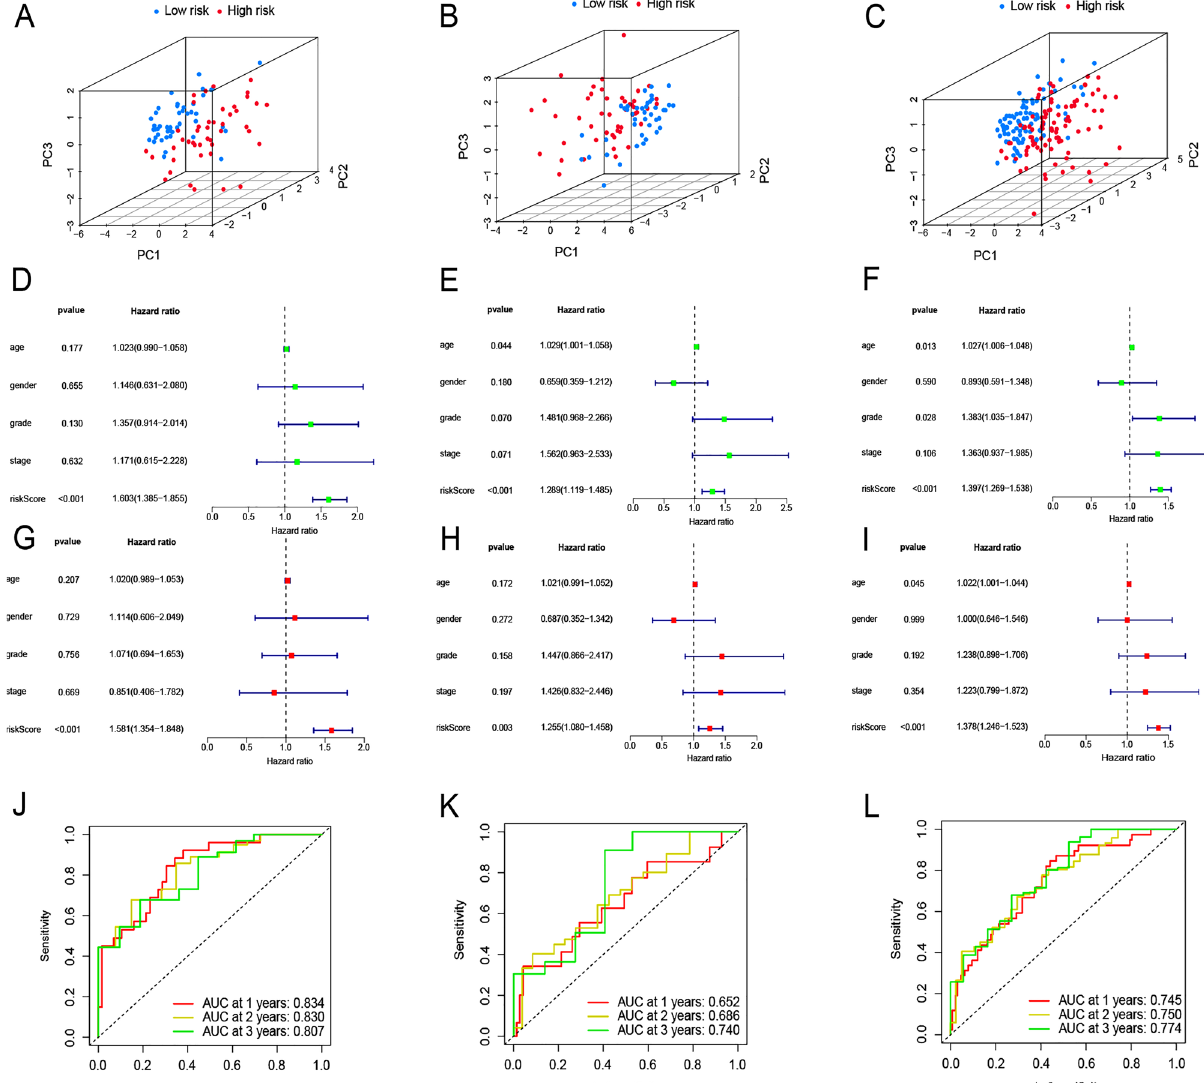
Figure 5. Evaluation of prognostic model efficacy. ( A – C ) Three-dimensional principal components analysis (3dPCA) of the high- and low-risk groups in the training set, validation set, and full dataset. ( D – F ) Univariate regression of the prognostic model in the training set, validation set, and full dataset. ( G – I ) Multifactorial regression of the prognostic model the training set, validation set, and full dataset. ( J – L ) ROC curves for 1 year, 2 years, and 3 years post-diagnosis the training set, validation set, and full